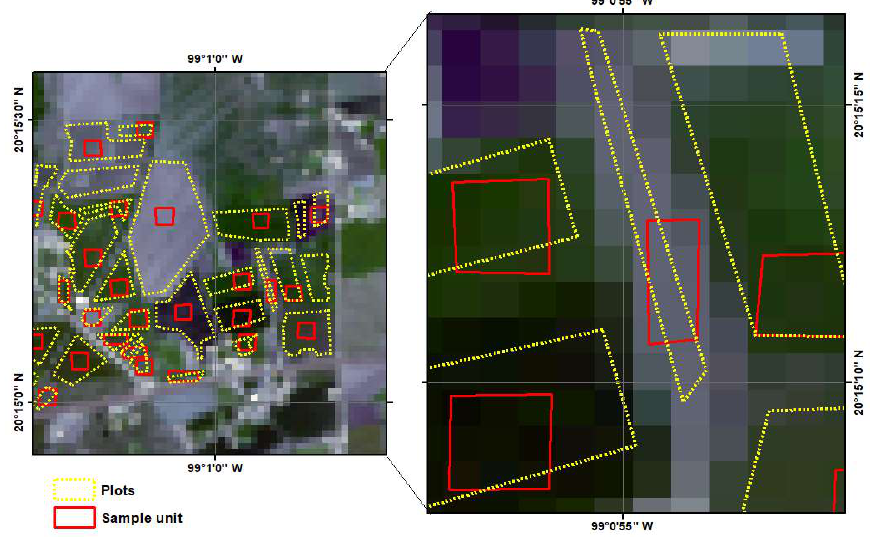
Figure 6. Sample sizes: 3 × 3 pixels ( left ), 2 × 5 pixels ( center ) and 2 × 4 pixels ( right ). (c) Satellite images used